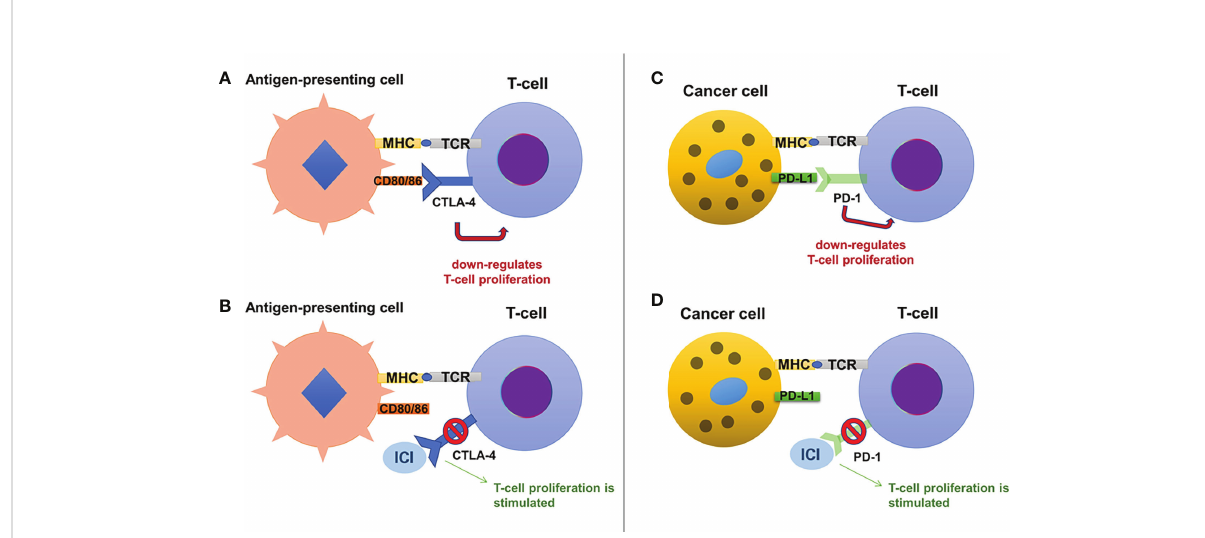
FIGURE 1 The mechanisms of action for immune checkpoint inhibitors include the CTLA-4 pathway (on the left, panels (A) and (B) ) and the PD-1/PD-L1 pathway (on the right, panels (C) and (D) ). Normally, CTLA-4 is present on the surface of T-cells and by binding to its ligands, CD80 and CD86 (expressed on antigen-presenting cells), it exerts an inhibitory effect on the T-cell proliferation (A) . Anti-CTLA-4 antibodies (a variety of ICIs) bind to CTLA-4 and block its inhibitory effects, stimulating T-cell proliferation (B) . Similarly, T-cells express PD-1, which binds to its ligand, PD- L1, present on cancer cells, suppressing T-cell proliferation (C) . Anti-PD-1 antibodies bind to PD-1 blocking its inhibitory effects and stimulating T-cell proliferation (D)